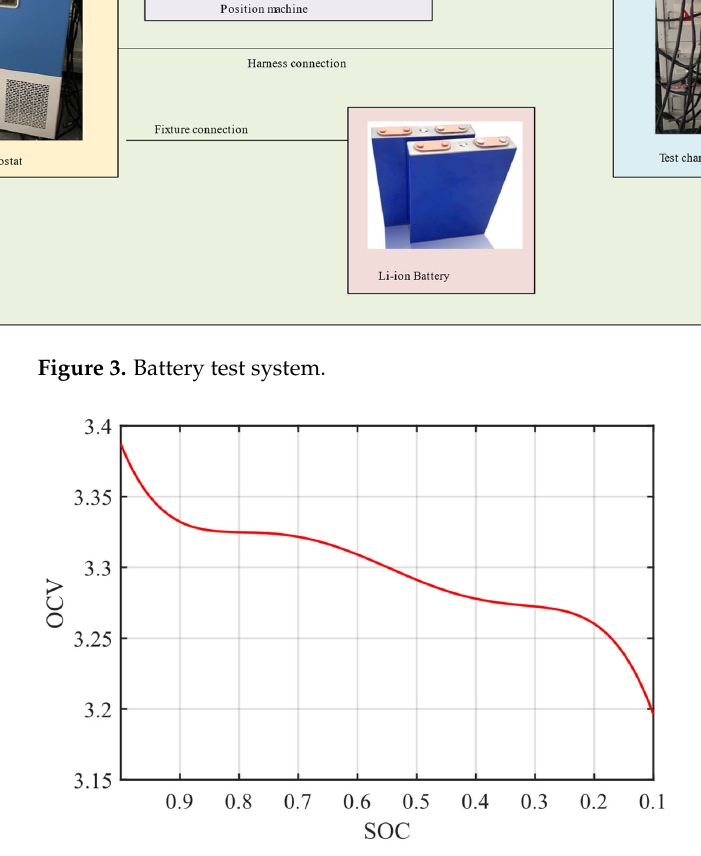
Figure 3. Ba tt ery test system. Table 2. Ba tt ery parameters.